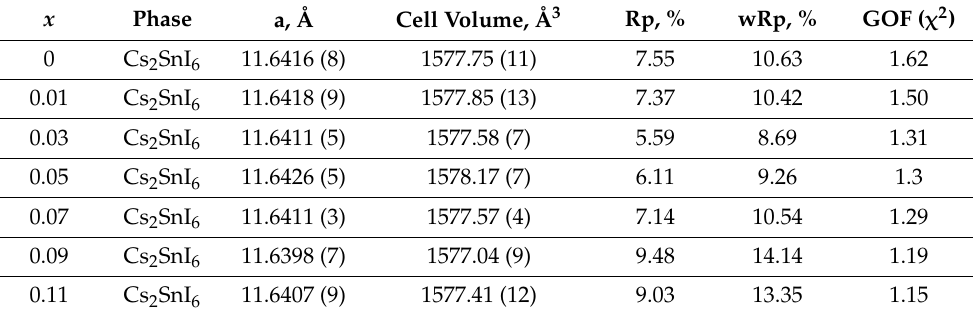
Table 1. Calculated cell parameters for the Cs 2 Sn 1 − x Ga x I 6 − x samples (SS